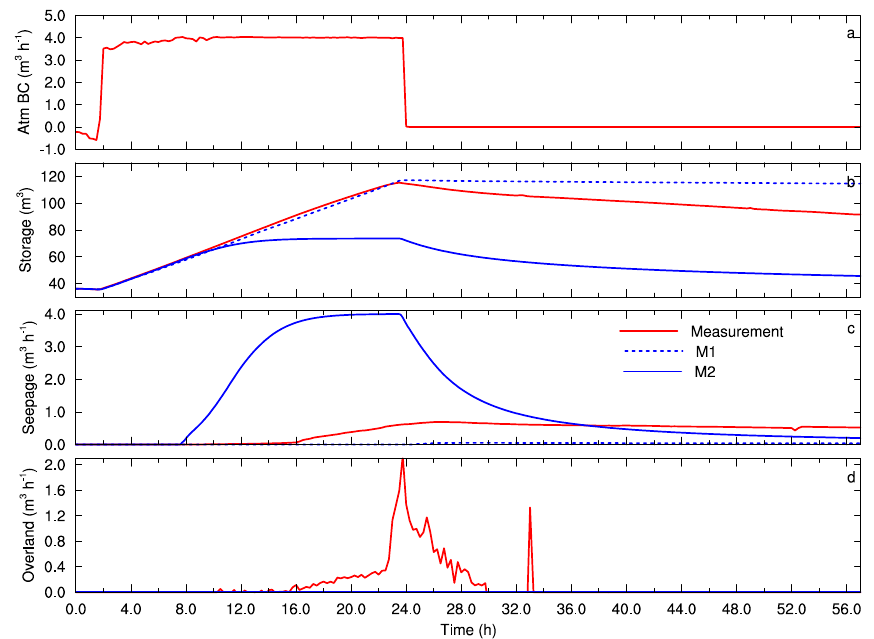
Figure 2. Comparison between the measured data and the modeling results from scenarios M1 and M2. From the upper panel to the lower panel are the atmospheric boundary conditions (m 3 h − 1 ), total water storage (m 3 ), seepage face flow (m 3 h − 1 ), and overland flow (m 3 h − 1